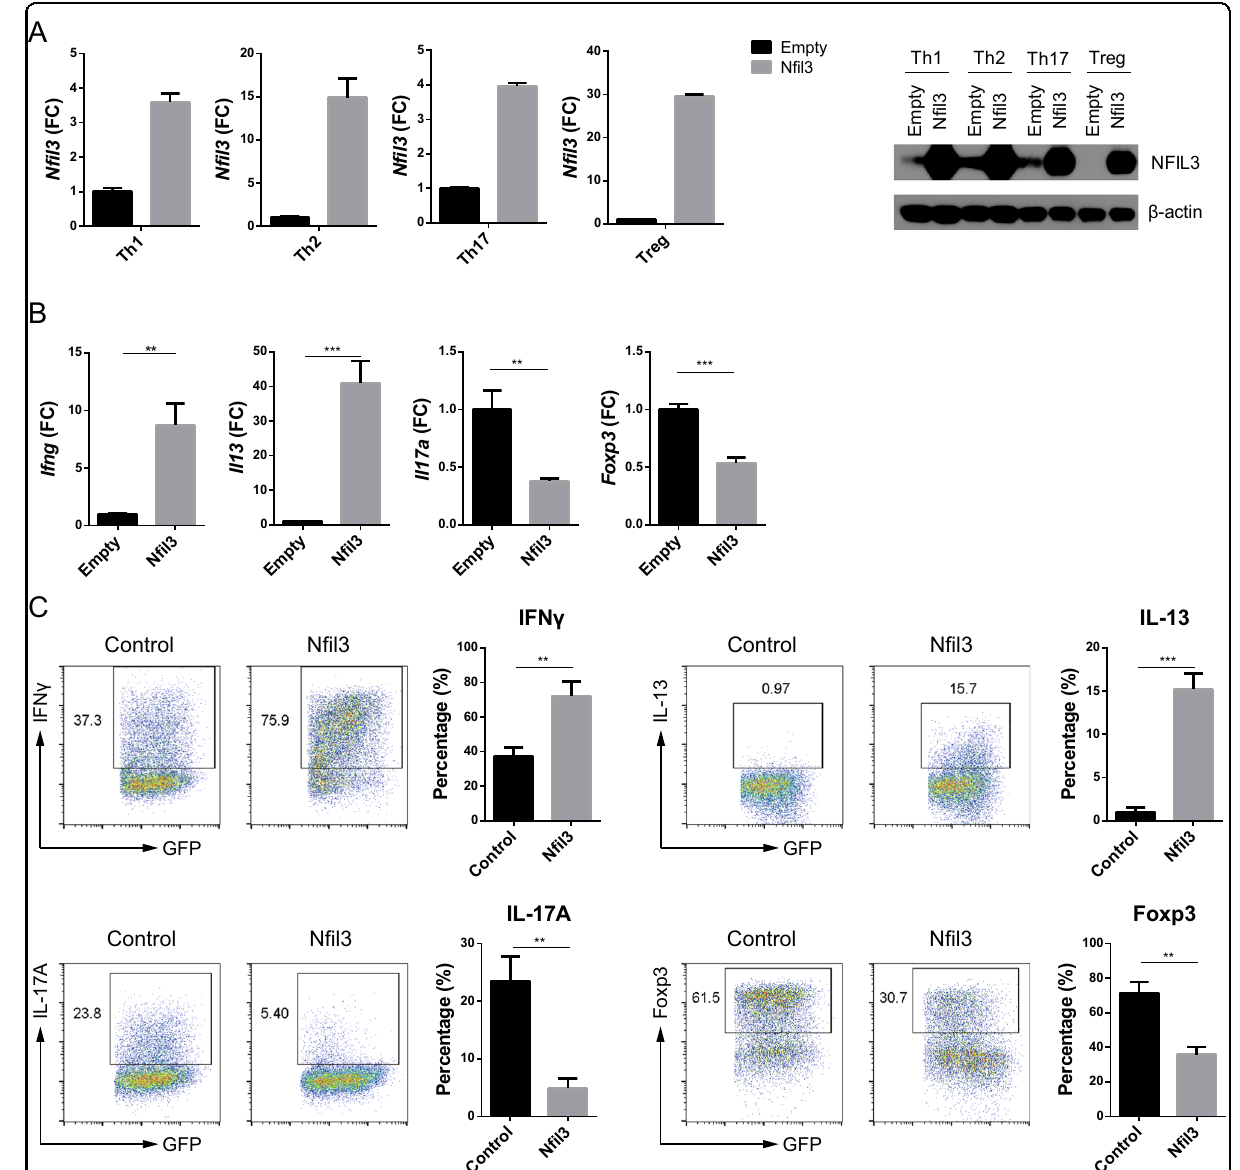
Fig. 3 Overexpression of N fi l3 attenuates Foxp3 expression in Treg cells. a Levels of N fi l3 mRNA in control and N fi l3 -overexpressing CD4 T cells were determined by qRT-PCR (left panel) and western blot (right panel). Naive CD4 T cells were transduced with control (empty) or N fi l3 -expressing vectors and polarized into each T-cell subset. Signature gene expression levels were measured in each CD4 T-cell subset by qRT-PCR ( b ), and protein levels in GFP-positive cells were evaluated by fl ow cytometry ( c ). Cells were cultured as described in a . qRT-PCR and dot plot data are representative of three individual experiments, and data in c , pooled from three individual experiments, were included in the statistical analysis. Error bars represent the SD. The signi fi cance of differences between groups was determined using Student ’ s t test. * P < 0.05, ** P < 0.01, *** P < 0.001, and **** P < 0.0001, n.s. not signi fi